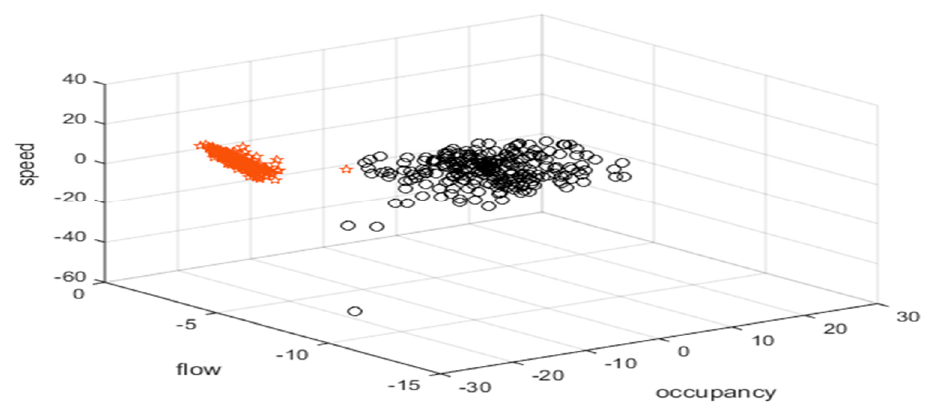
Figure 9. Distribution of traffic flow data at 15 s interval with and without sudden fire disasters.